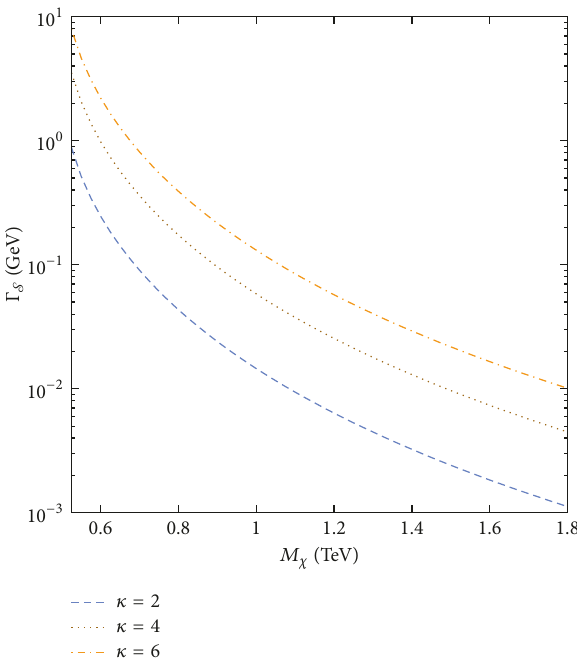
Figure 3: Total width of S for 𝑀 S = 1 TeV as functions of 𝑀 𝜒 for 𝜅 = 2, 4,6 assuming Λ = 5 TeV.